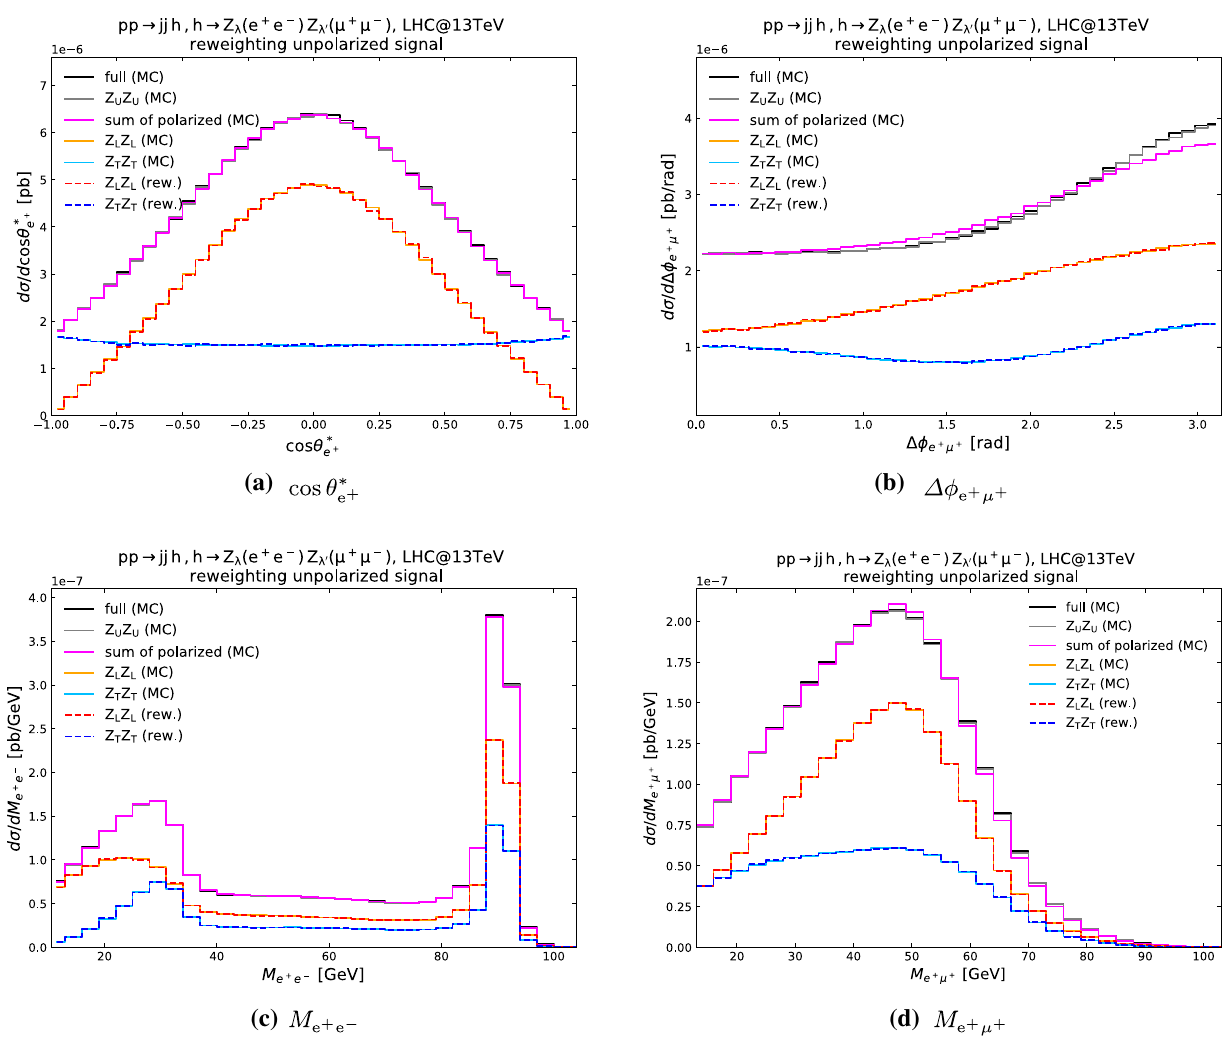
Fig. 2 Differential cross-sections for VBF Higgs production at the LHC@13TeV: cosine of the positron decay angle in the correspond- ing Z boson rest frame ( a ), azimuthal difference (in the Higgs rest frame) between the positron and the antimuon ( b ), invariant mass of the positron-electron pair ( c ) and of the positron-antimuon pair ( d ). Com-